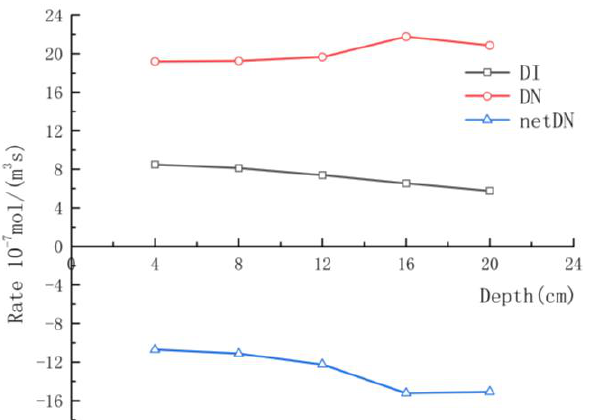
Figure 11. Nitrification, denitrification, and net denitrification rates for different burial depths.